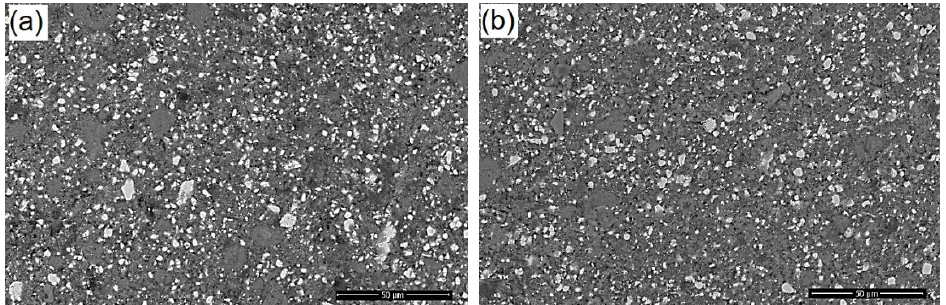
Figure 9. Back scatter SEM images with high magnification recorded on the surface of ( a ) neat sealer and ( b ) modified sealer, at the interface with root canal area.